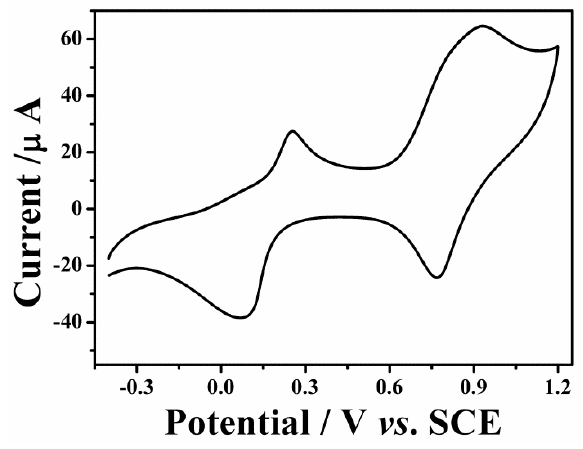
Figure 4. Cyclic voltammogram (CV) of the magnetite PB nano-composites modified glassy carbon electrode (GCE) in 0.1 M PBS (pH 6.0) with the scan rate of 100 mV ∙ s − 1 .